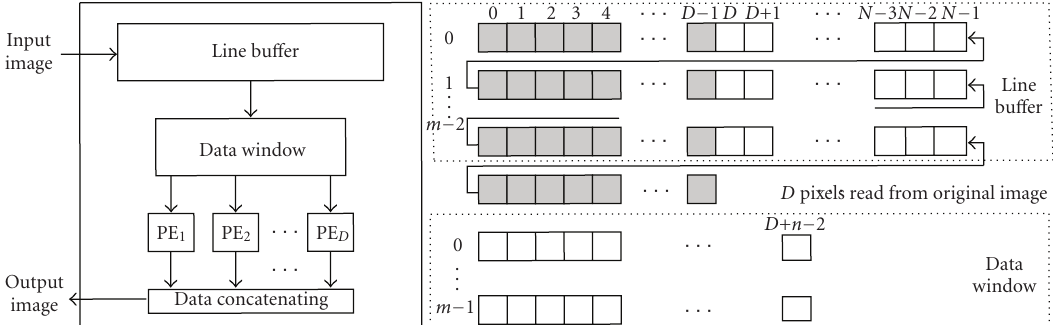
Figure 11: Diagram of the algorithm logic in edge detection.